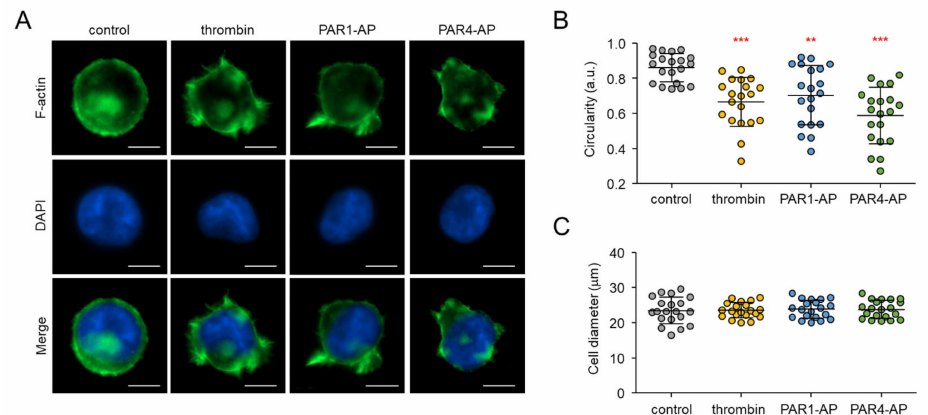
Figure 3. Morphological changes induced by PAR1 and PAR4 activation in MEG-01 cells. ( A ) Repre- sentative images of F-actin-stained MEG-01 cells. MEG-01 cells were treated with PAR1-AP (100 µ M), PAR4-AP (100 µ M), or thrombin (0.1 U/mL) for 30 min and fixed, and then labeled with phalloidin- FITC (green). Nuclei were stained with DAPI (blue). Scale bar = 10 µ m. ( B ) Measurement of the circularity of MEG-01 cells. The circularity was measured using Lionheart software. Each dot corre- sponds to individual analyzed cells. A total of 20 cells were analyzed for each group (mean ± S.D., n = 20). ( C ) Measurement of diameter of MEG-01 cells. The diameter was measured using Lionheart software. For each group, 20 cells were analyzed (mean ± S.D., n = 20); ** p < 0.01, *** p < 0.001. The platelet-like morphological changes were quantitatively analyzed using circularity measurement. For the analysis, 20 cells were randomly selected for each group. The